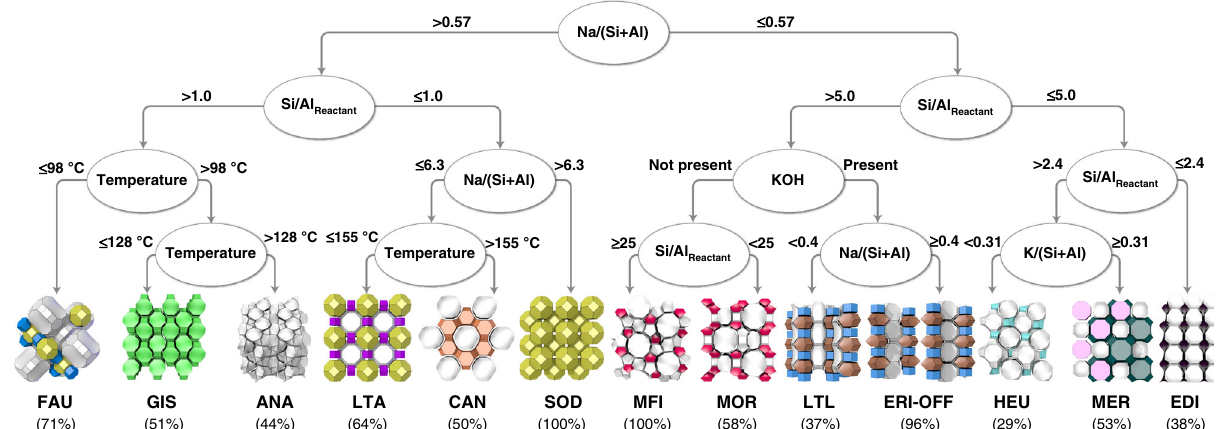
Fig. 3 Decision tree constructed from the trained model with the highest accuracy of the XGBoost. In OSDA-free synthesis of zeolites, the most signi fi cant synthesis descriptors for zeolite phase selection are the amounts of SiO 2 , Al 2 O 3 , MOH (M = Li, Na, K, etc.), and H 2 O present in the synthesis mixture. Machine learning models including XGBoost, support vector machine, decision tree, and random forest were trained to predict synthesis results from synthesis descriptors including temperature, heating time, and chemical compositions with different standard denominators. The trained model with the highest accuracy was the XGBoost model using (Si + Al) as the denominator, and this model was interpreted as a decision tree shown here with a depth of